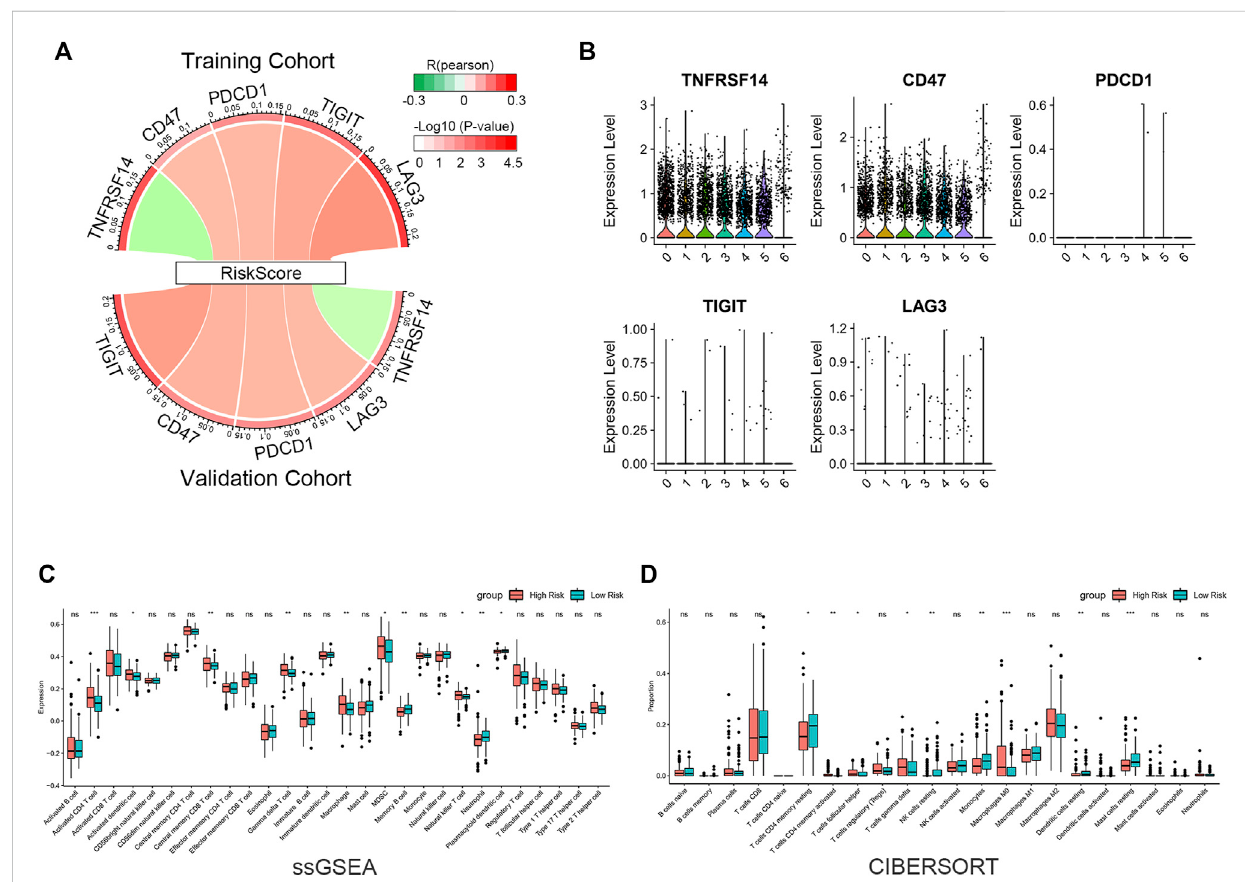
FIGURE 7 Immune in fi ltration re fl ected by gene signature. (A) Correlation betweenriskscore and inhibitory ICs. The R-value is shown by theband ’ s width. The p -valueis indicated bytheband ’ scolor. The correlation wasexaminedusing Pearson correlationanalysis. (B) Expression levels of inhibitory ICs invarious subtypesofcancercells. (C) Comparisonof28immunecellenrichmentscores. (D) Comparisonofthedifferenceintheabundanceofimmunein fi ltrating cells by the CIBERSORT algorithm. The signi fi cance of the difference was tested with Wilcoxon test. * p < 0.05, ** p < 0.01, and *** p <